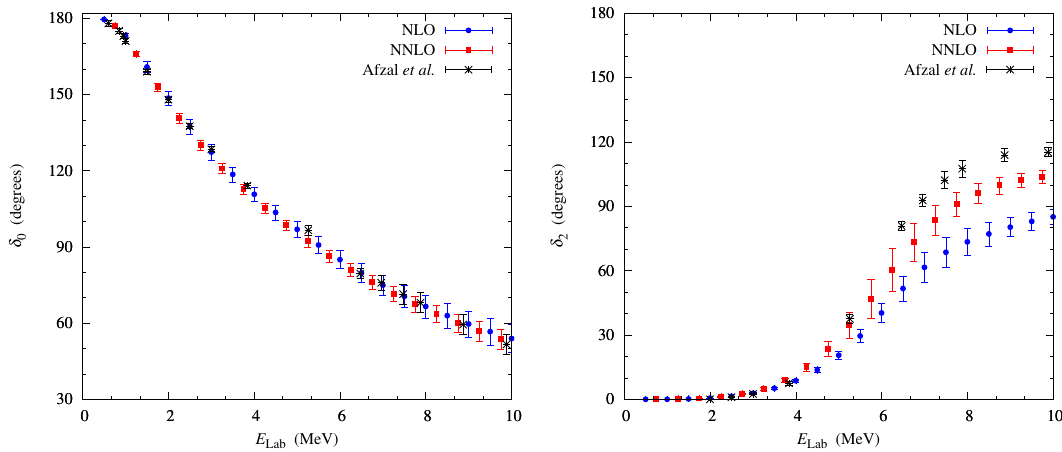
Figure 1 . Left panel: S-wave α - α scattering phase shift δ 0 versus the energy in the laboratory system, E . Right panel: D-wave α - α scattering phase shift δ lab system, E . The blue circles and red squares represent our predictions at NLO and NNLO, lab respectively, while the data are given by the black